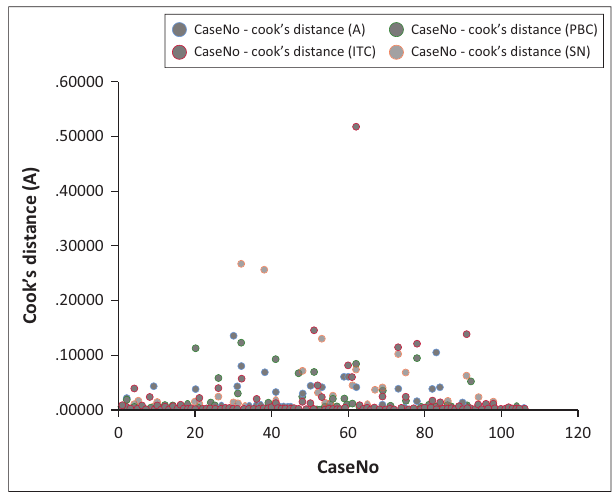
FIGURE 2: Scatter graph showing non-significant outliers and influential.